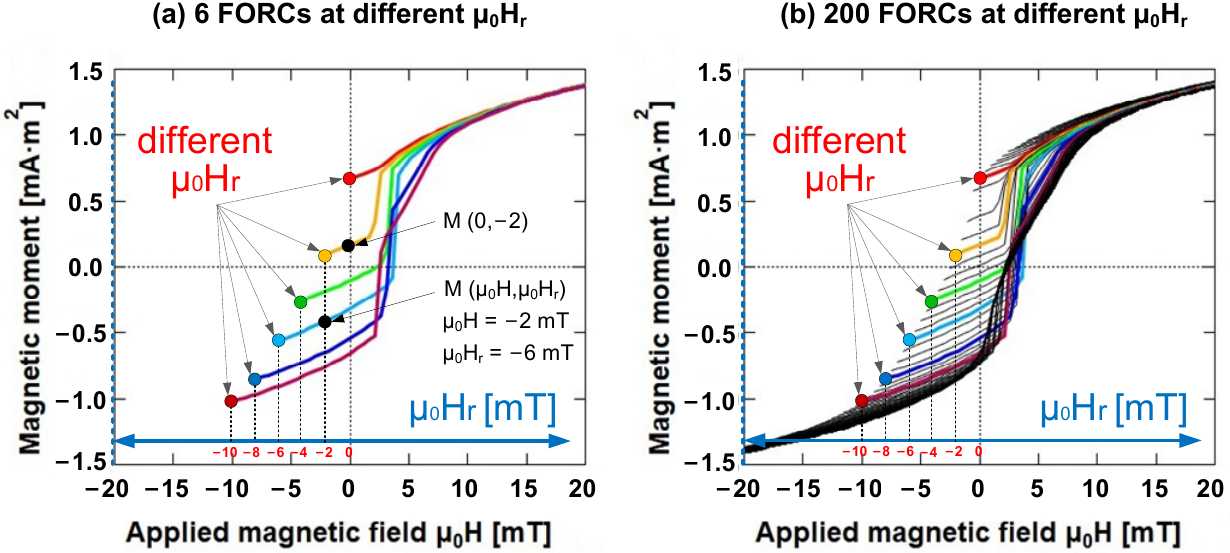
Figure 3. Example of FORCs of Wiegand wire at various μ 0 H r . ( a ) 6 FORCs at various μ 0 H r . Two black points of magnetization on multiple FORCs at two applied magnetic fields ( μ 0 H) with two reversal fields ( μ 0 H r ) are represented by M ( μ 0 H = − 2 mT, μ 0 H r = − 6 mT) and M ( μ 0 H = 0 mT, μ 0 H r = − 2 mT), respectively; ( b ) 200 FORCs at various μ 0 H r .